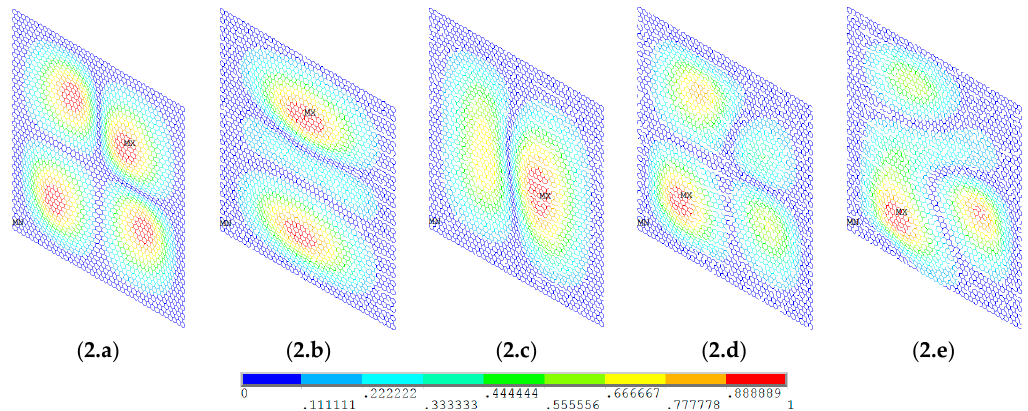
Figure 9. Vector sum of the displacement of graphene sheets. ( 1.a – 1.e ) First-order buckling mode; ( 2.a – 2.e ) fourth-order buckling mode; ( a – e ) 0%, 1%, 2%, 3%, and 4% of vacancy defects, respectively.